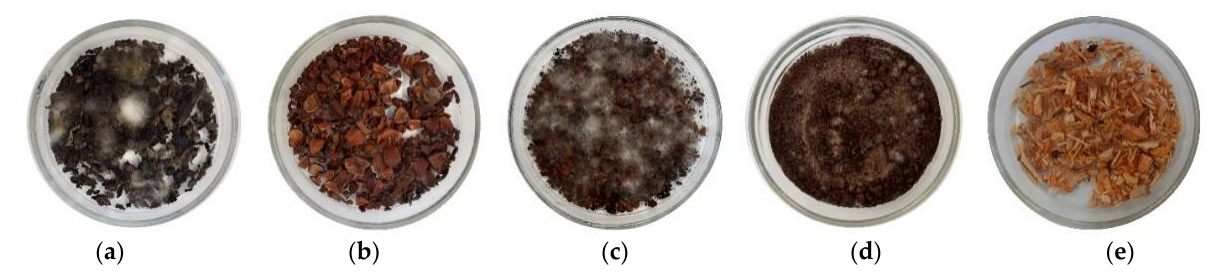
Figure 10. Mould growth (test without culture media) after four weeks of exposure: ( a ) grape press waste; ( b ) hazelnut shells; ( c ) olive press waste; ( d ) spent coffee grounds; ( e ) wood chips.